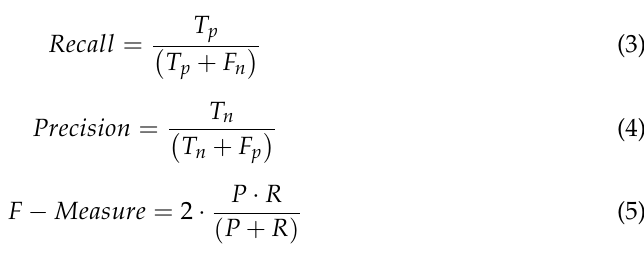
Table 3. Comparison of evaluation matrices in terms of different classifiers. Sl No. Model Accuracy